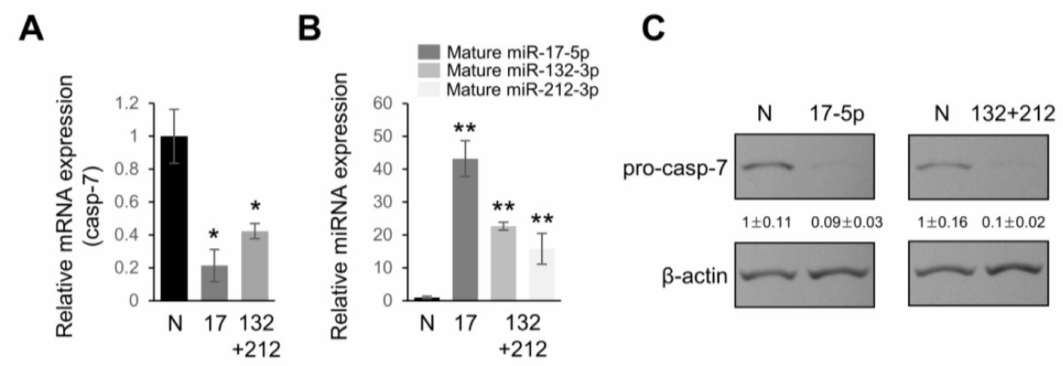
Figure 3. Caspase-7 (casp-7) is downregulated in miR-17-5p and miR-132-3p/-212-3p overexpressing